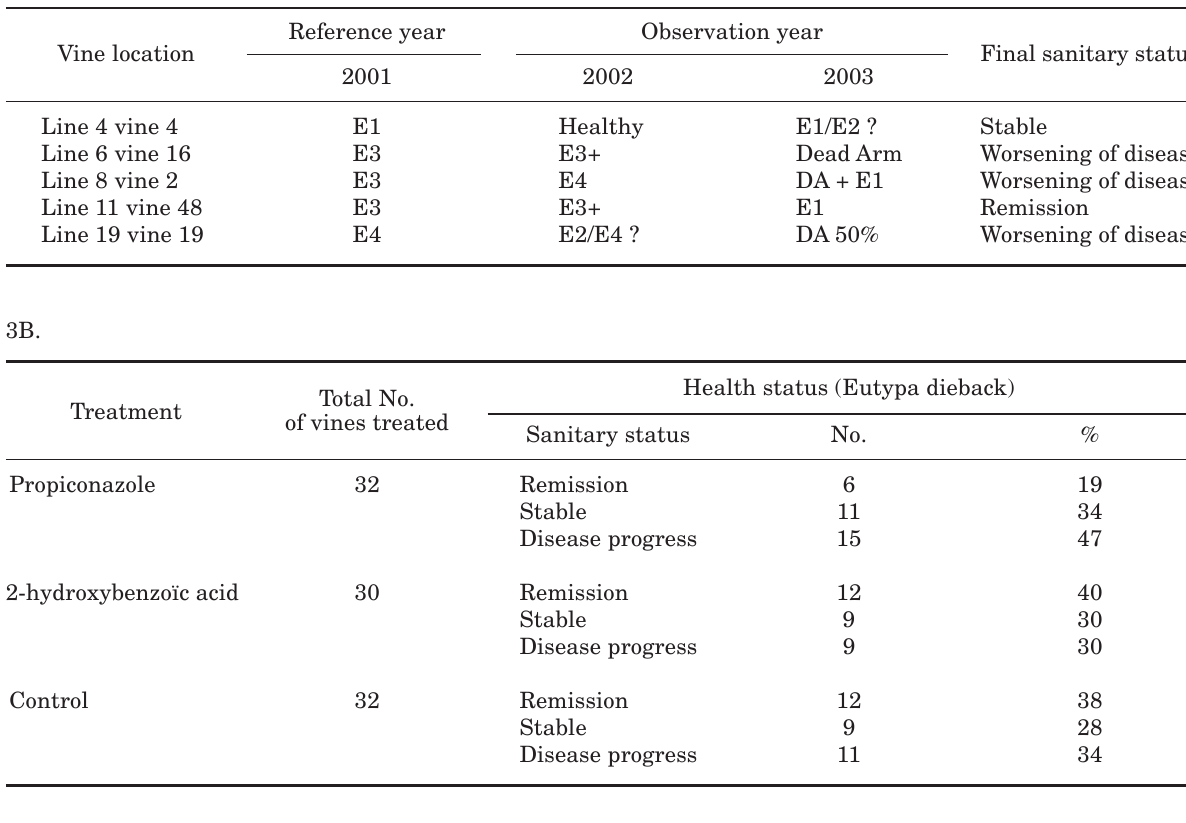
Table 3. Example of the analysis carried out with some of the data recorded in trial 2 (Martillac). A. The health status of the vine was determined before treatment; each vine was then ranged in one of 3 classes: remission, worsening of disease, or stable. B. Total No. per final sanitary status was calculated and compared.